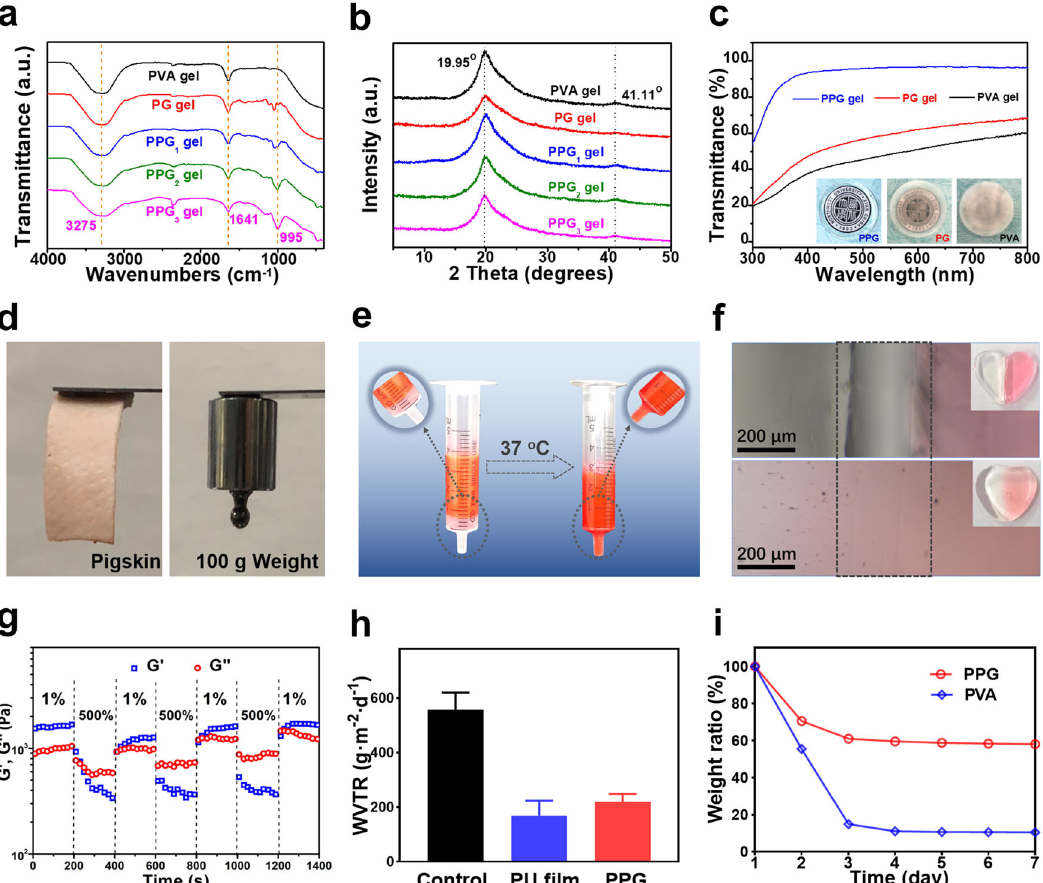
Fig. 2 Charcterization of PPG hydrogel. a FTIR spectra of the hydrogels. b XRD spectra of the hydrogels. c UV – vis spectra of hydrogels. Insert showing the optical transparency of the hydrogels. d Self-adhesion property of PPG hydrogel. e Self-adaptive property of PPG hydrogel marked with Rh B at 37 °C under gravity. f Optical microscope images of interface of the healed PPG hydrogel. Insert showing the healed PPG hydrogel. g Rheological property of PPG hydrogel at the alternate step strain test. h Breathability of PPG hydrogel and commercial PU fi lm. Error bars represent the standard deviation ( n = 3). i Weight losses of PVA and PPG